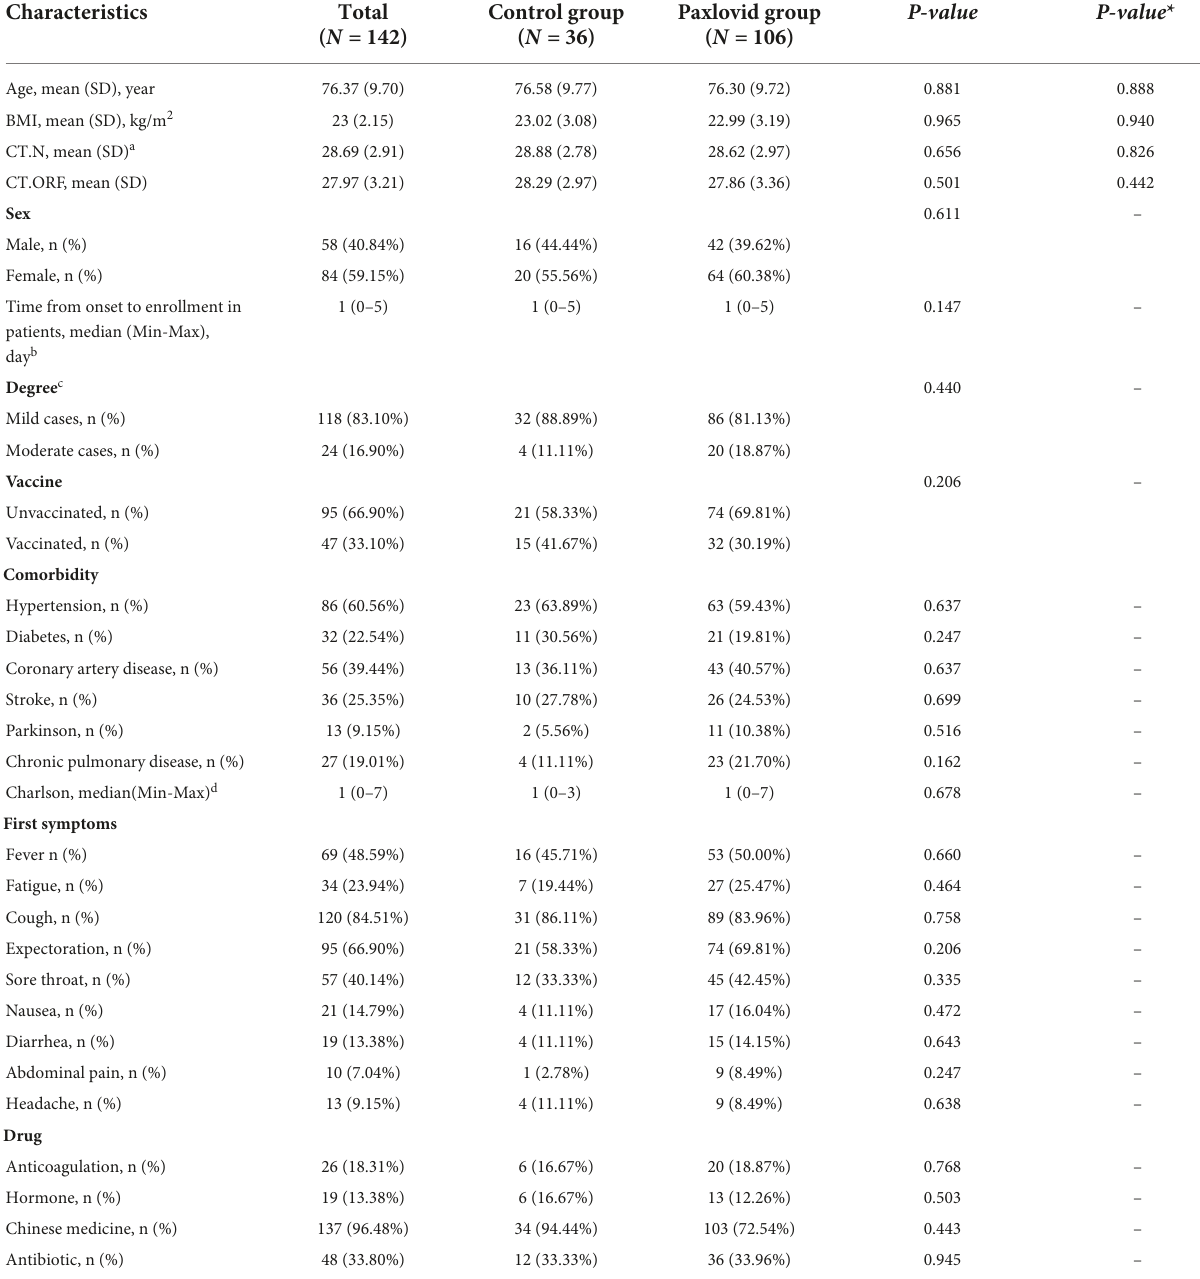
TABLE 1 Baseline characteristic of participations at the first